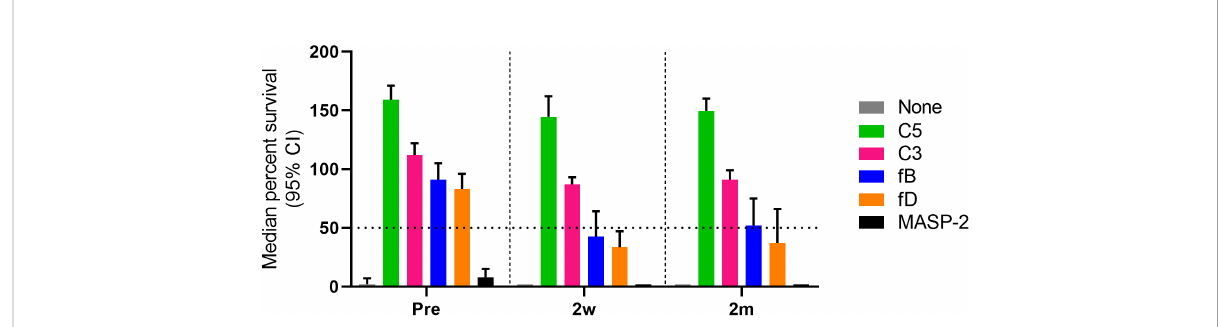
FIGURE 4 Comparative analysis of the effect of complement inhibitors on the survival of Hib in pre- and post-vaccination sera. Survival data for all subject/ Hib isolate combinations were cumulated (three technical replicates for each combination). The horizontal dotted line represents 50% survival of bacteria after 60 min incubation. Shown are results for the highest concentrations of complement inhibitors tested (25 µM for the fB inhibitor iptacopan and the fD inhibitor CMS487, 100 µg/mL for the C3 inhibitor CP-40, the anti-C5 mAb tesidolumab and the anti-MASP-2 mAb). CI, con fi dence interval.